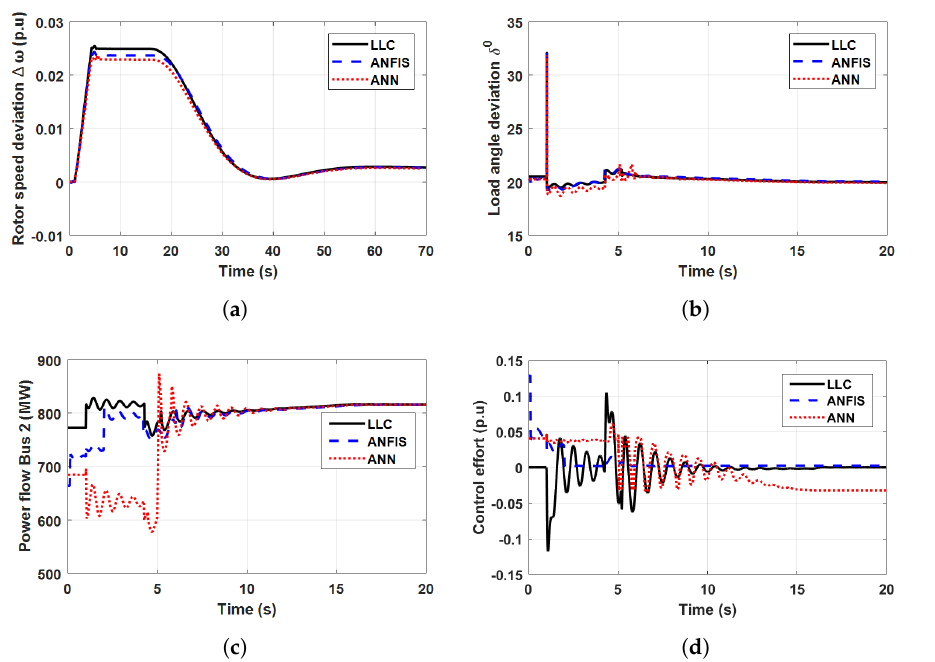
Figure 9. Case 2: Two-area power System with microgrid based on PV. ( a ) Rotor speed deviation. ( b ) Load angle deviation. ( c ) Flow of power through the line 2. ( d ) control